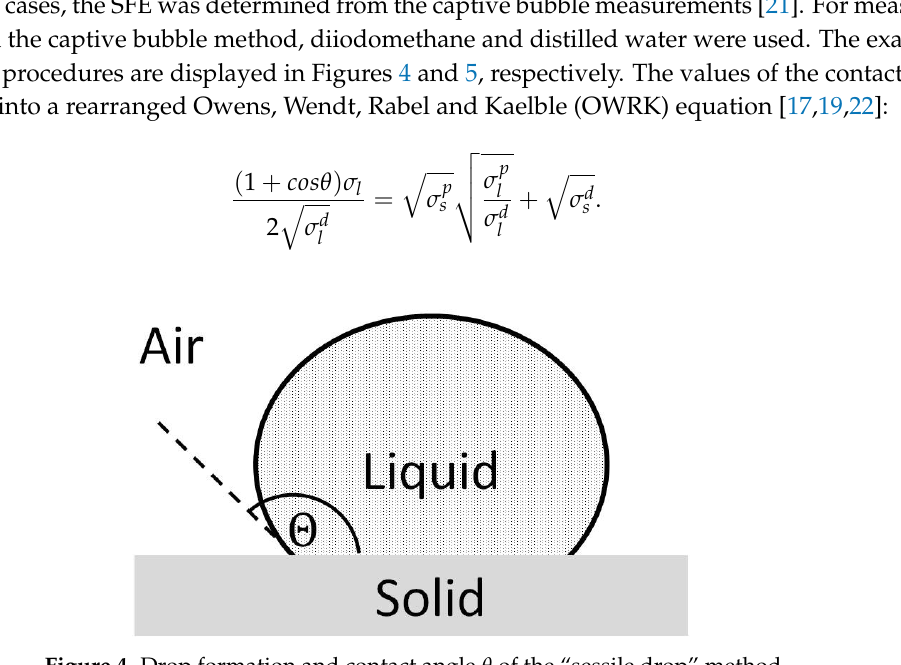
Figure 4. Drop formation and contact angle θ of the “sessile drop” method.